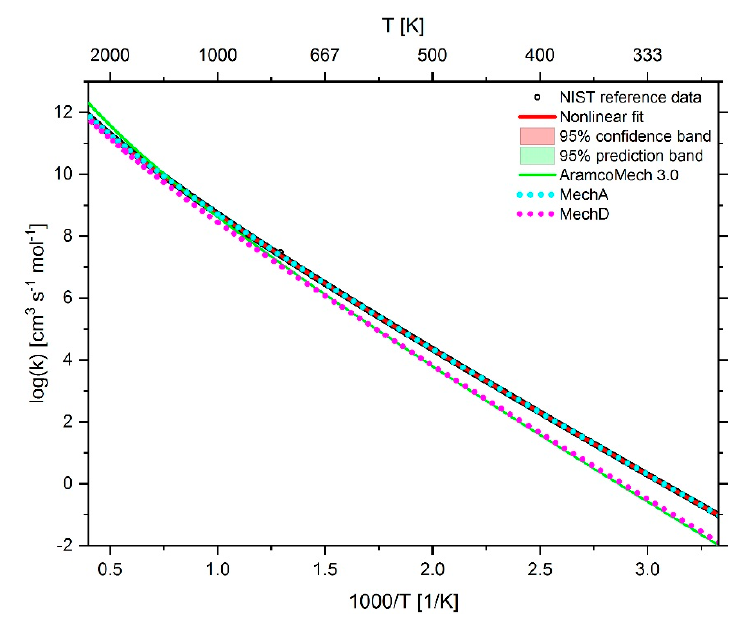
Figure 13. Comparison of the reaction rate coefficient of reaction 238 (C 3 H 8 + HO 2 ↔ n -C 3 H 7 + H 2 O 2 ) of MechA, MechD and AramcoMech 3.0 as well as the fitted rate coefficient using reference data from the NIST database.